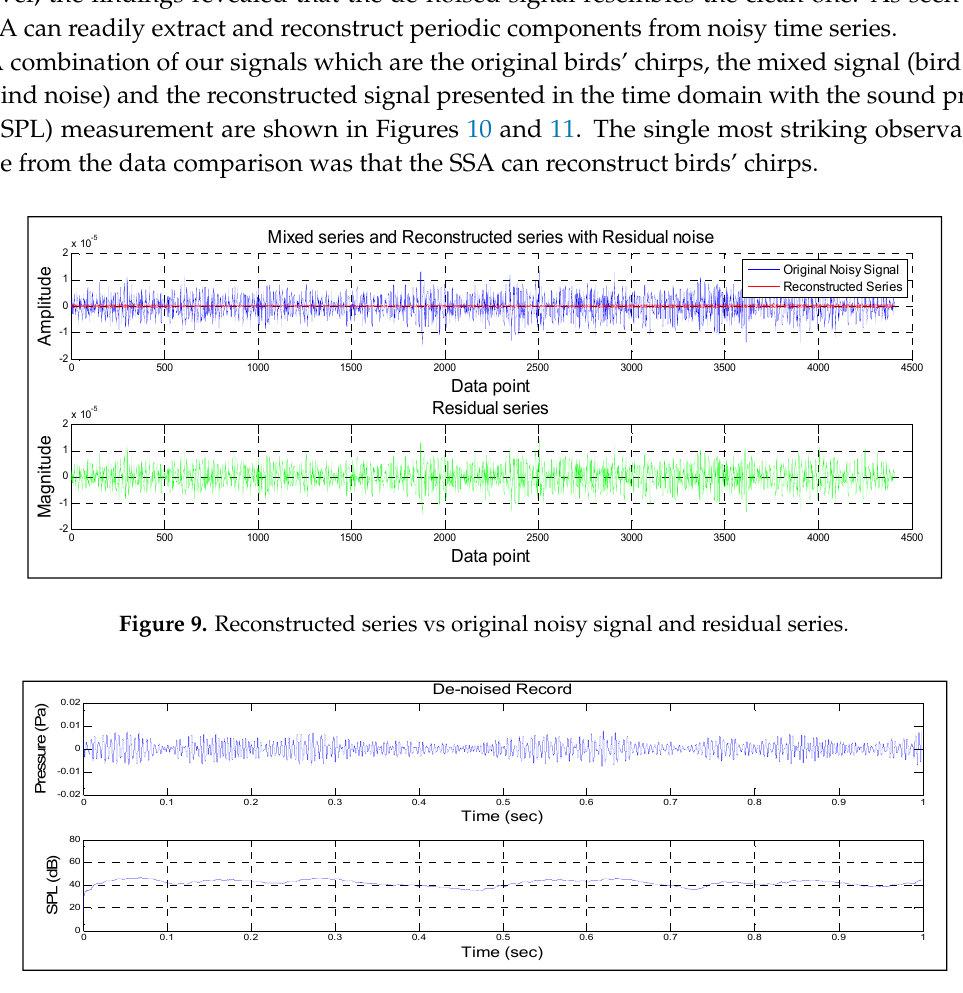
Figure 10. The de-noised record was separated by retaining only the leading two pairs of the eigenvalues.